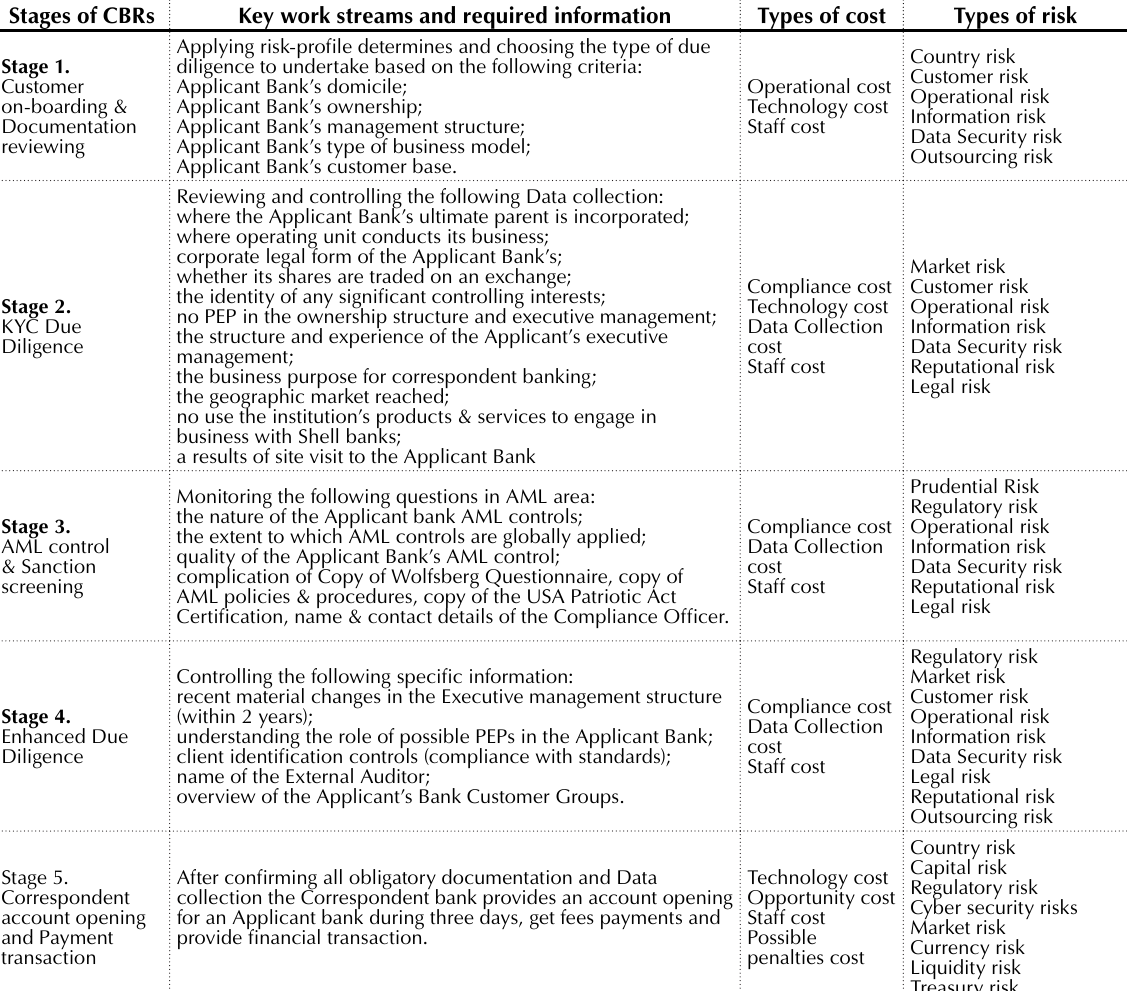
Table 1. Types of cost and risk by obligatory stages of CBRs Stages of CBRs Key work streams and required